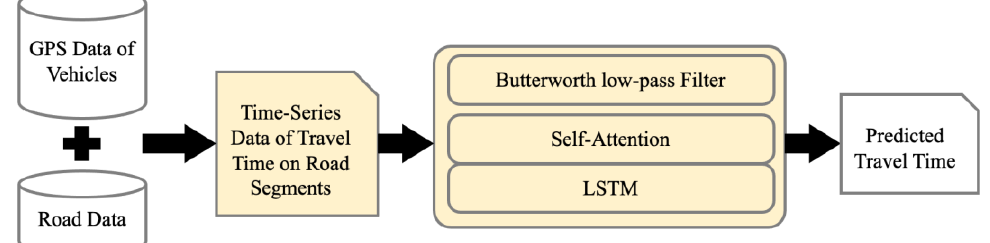
Figure 5. Our overall approach. The time-series data, which are created from Global Positioning System (GPS) data and road data, were passed through a filter to be used as an input of the Self- Attention Long Short-Term Memory (LSTM). The predicted travel time was the output.